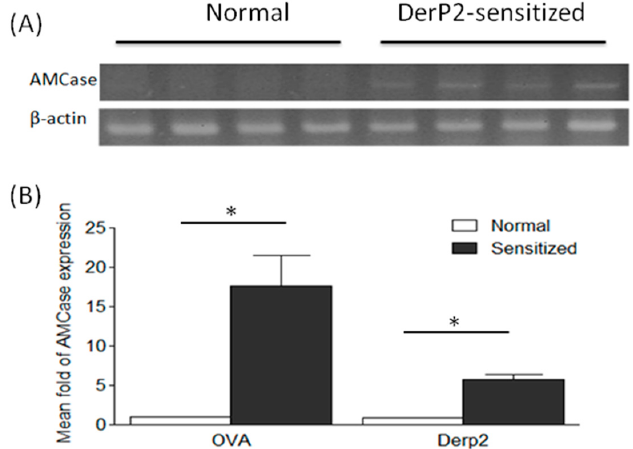
Figure 1. The elicited AMCase expression levels in the mice sensitized with OVA and Der-P2. The lung samples were harvested from normal saline controls, ovalbumin (OVA)- or Dermatophagoides pteronyssinus group II allergen (Der P2) mice at day 28. (The number of mice in each group was more than four.) Their AMCase expression was quantified via ( A ) RT-PCR and ( B ) real-time PCR (* p < 0.05, normal vs. sensitized, nonparametric Mann-Whitney U test).